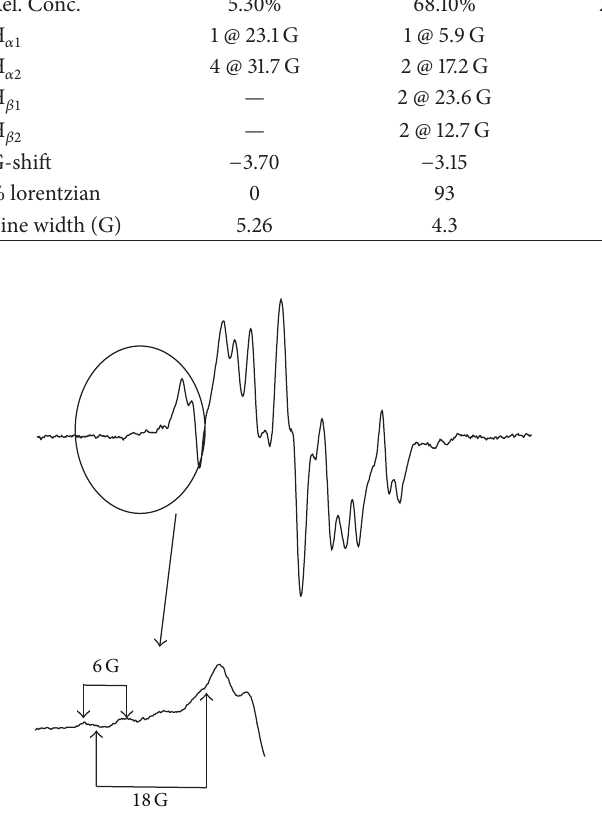
Figure 5: ESR spectra of 65kGy irradiated UHMWPE powder (pristine (a) and vitamin E blended (b)).